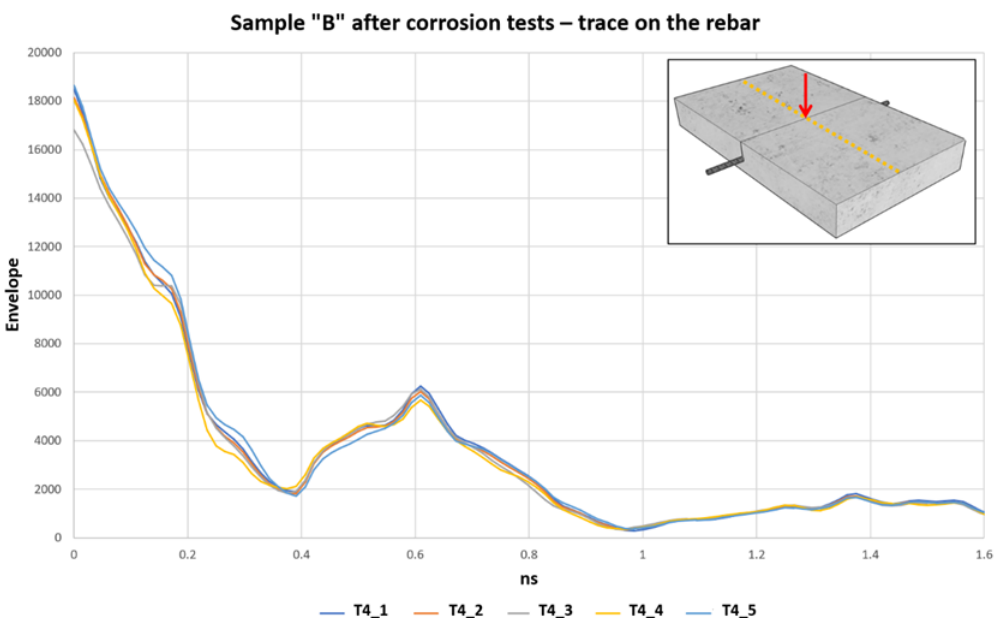
Figure 13. Envelope A-scan was acquired on sample “B” after an accelerated corrosion test. The trace shown is taken from radargram 29 on the steel rebar.